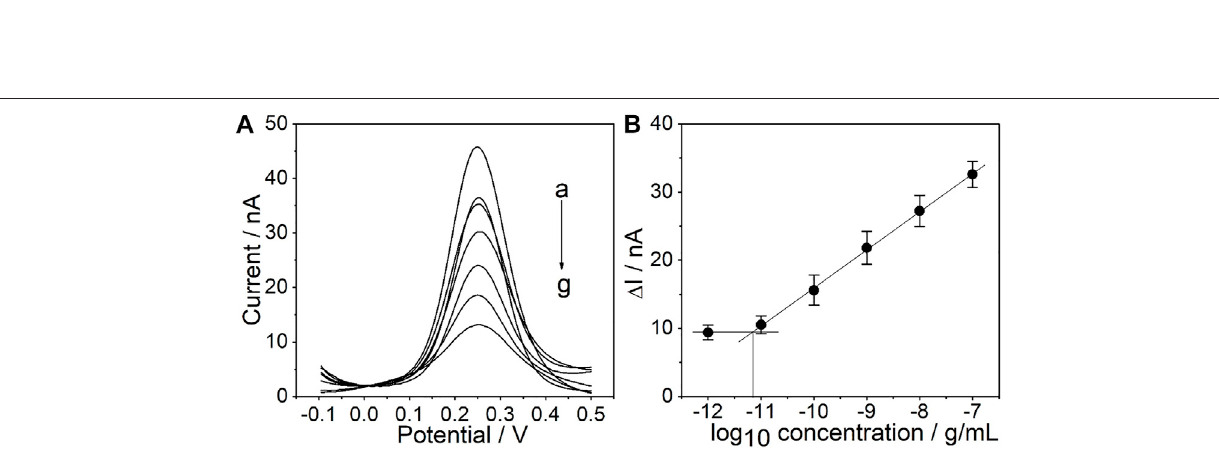
Frontiers in Chemistry |